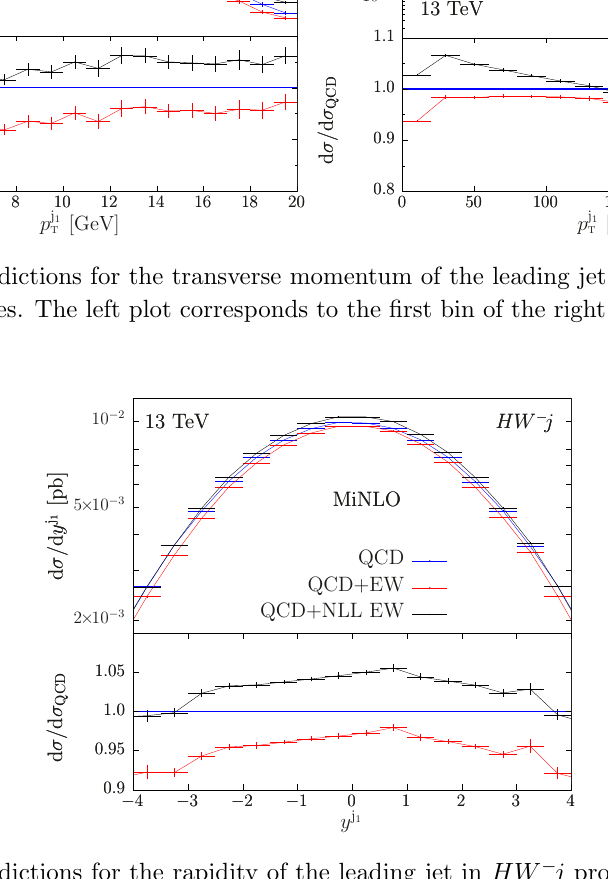
Figure 7. NLO predictions for the rapidity of the leading jet in HW (cid:0) j production. Same curves and labels as in (cid:12)gure